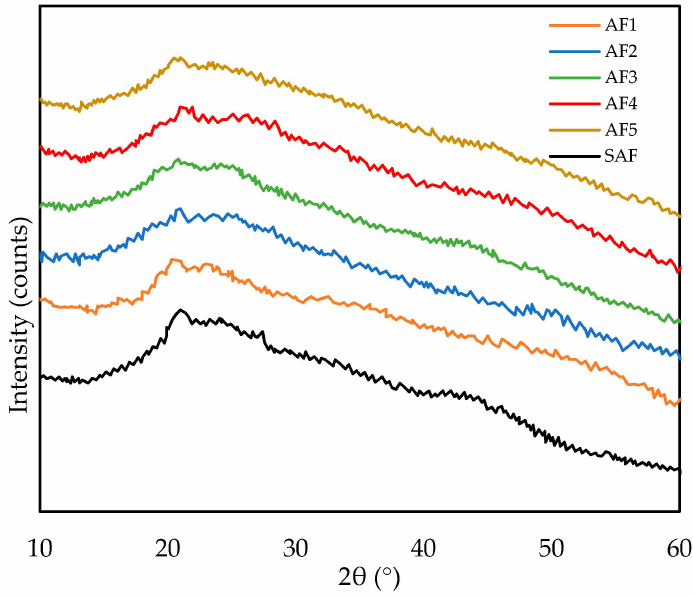
Figure 2. Diffractograms of AFs. (SAF: standard adhesive formulation; AF1: Thymus bleicherianus ; AF2: Thymus capitates ; AF3: Thymus satureioides ; AF4: Thymus vulgaris ; AF5: Thymus zygis ).